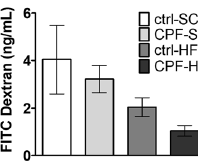
Figure 3. FITC dextran assays in plasma 2.5 h after oral administration in male offspring at young adult age from CPF and/or HFD exposed mothers. Values are expressed as the mean ± SEM (n = 5–20) using the analysis of variance (ANOVA) and a subsequent post hoc Bonferroni test. ctrl control, CPF Chlorpyrifos, HF high fat, SC standard chow, FITC fluorescein isothiocyanate.